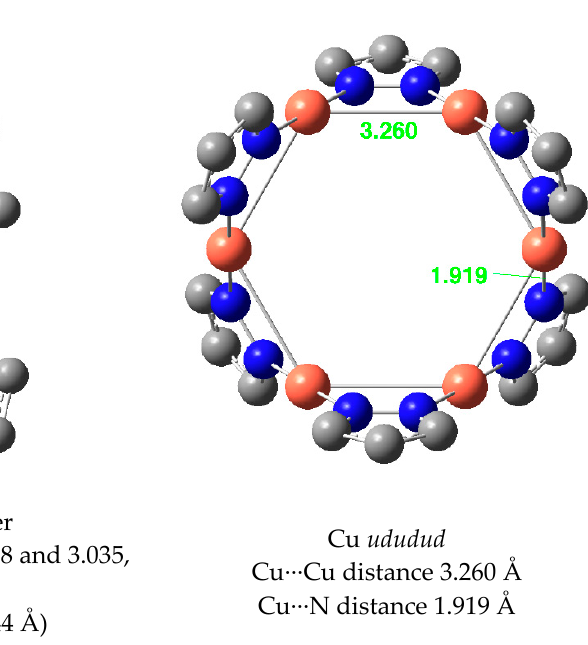
Figure 15. Optimized structures of Cu(I) pyrazolates.